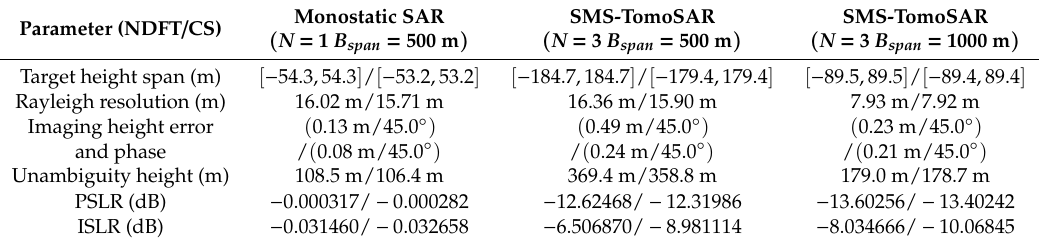
Table 4. The imaging performance results of SMS-TomoSAR and monostatic SAR for the NDFT and CS algorithms.